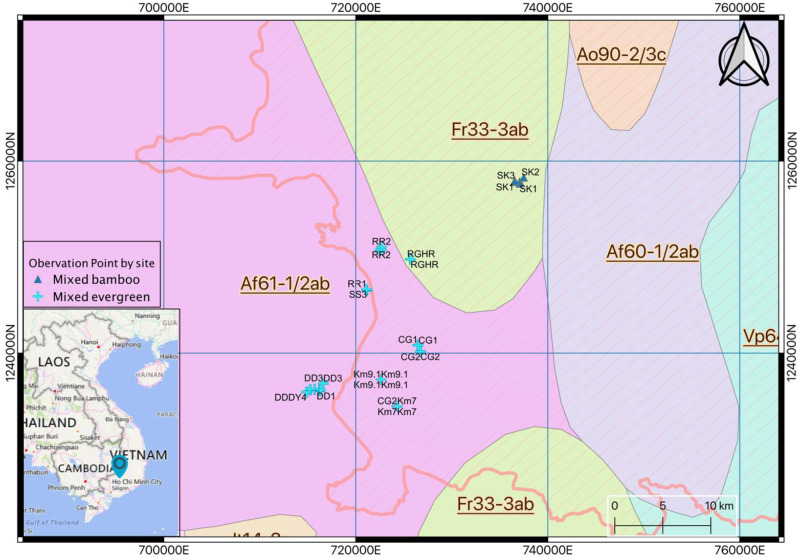
Location of study site and plots in Dong Nai Province, Vietnam.Colours on the basemap represent forested (green) and unforested (yellow and brown) land cover. The land cover basemap, country and province borders were sourced from NaturalEarth (http://www.naturalearthdata.com/about/terms-of-use/).